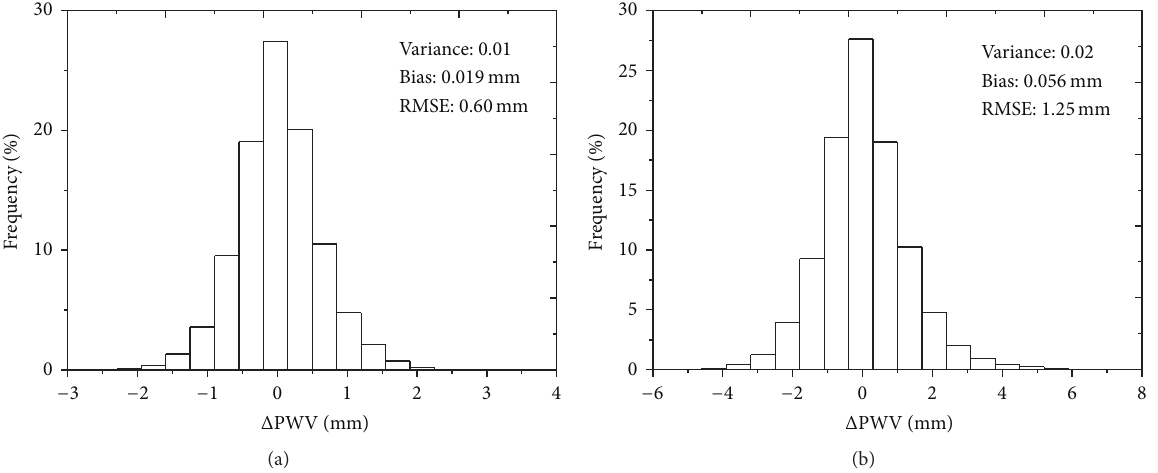
Figure 4: Histograms of errors between the newly estimated PWV (using the new LSE, which includes added errors) and the original PWV when (a) the standard deviation of the LSE errors is 0.01 and (b) the standard deviation of the LSE errors is 0.02.